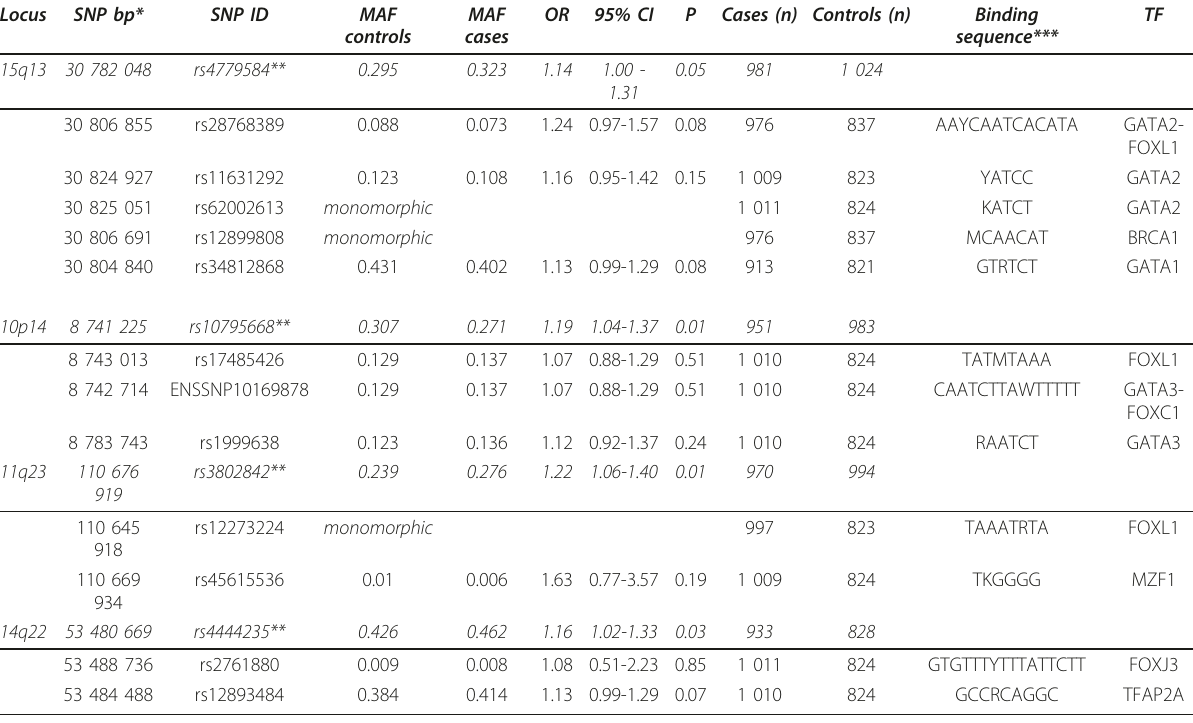
Table 1 Genotyping of 12 SNPS that locate in transcription factor binding sites in low-penetrance CRC loci Locus SNP bp* SNP ID MAF